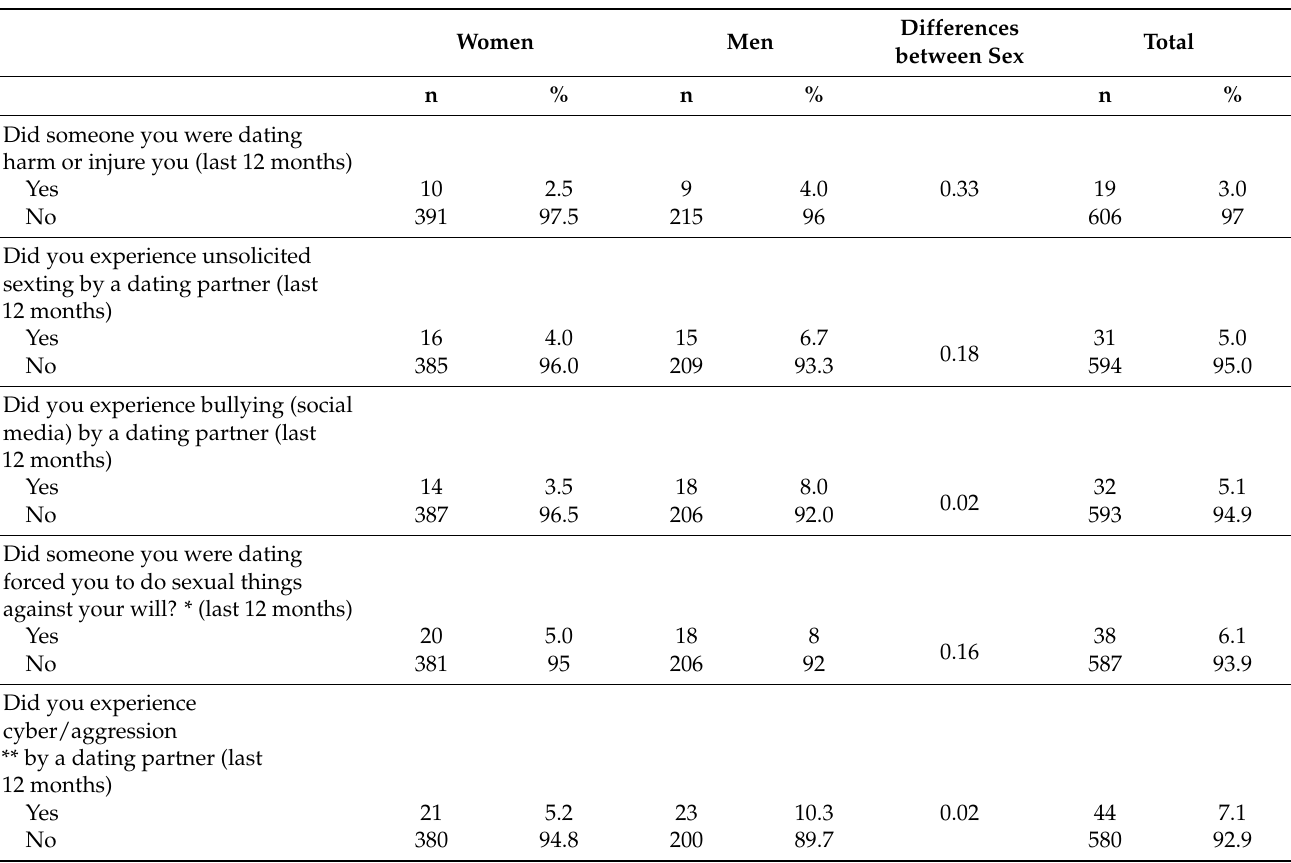
Table 2. Prevalences of physical abuse, unsolicited sexting, bullying, sexual abuse, and cyber- aggression by gender and dating